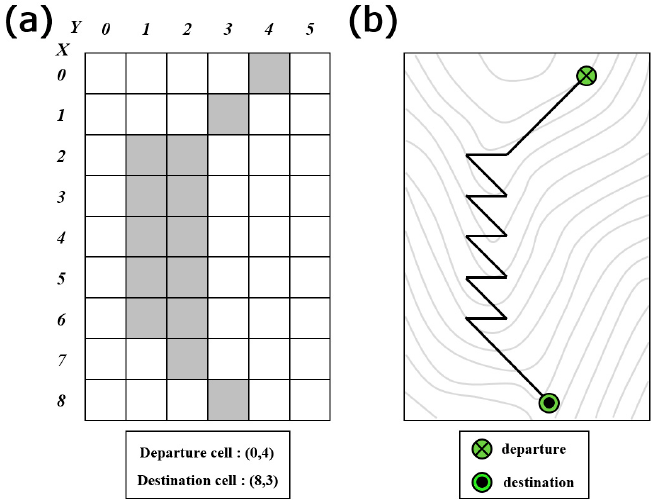
Fig 3. Figure 2. Example of a zigzag-shaped path obtained by least-cost path analysis. ( a ) Least-cost travel path analyzed with a raster surface; ( b ) Result of converting the travel path with a raster structure into a path with a vector